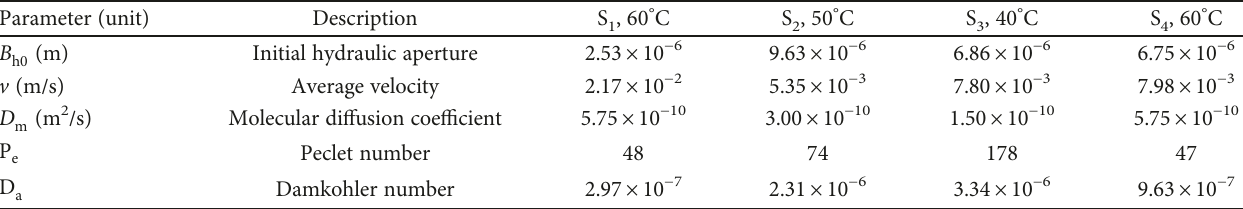
is from You et al., [47]). m